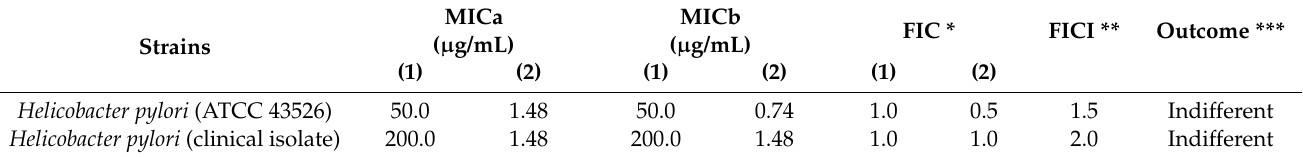
Table 2. Determination of the synergistic activity of the hydroalcoholic extract of Brazilian red propolis in combination with tetracycline against Helicobacter pylori strains (ATCC 43526 and clinical isolate). MICa Strains Helicobacter pylori (ATCC 43526) 50.0 Helicobacter pylori (clinical isolate) 200.0 MICa—minimal inhibitory concentration